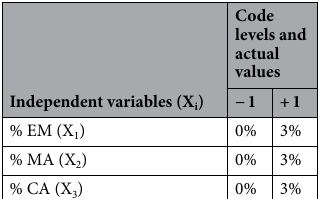
Independent variables (X i )